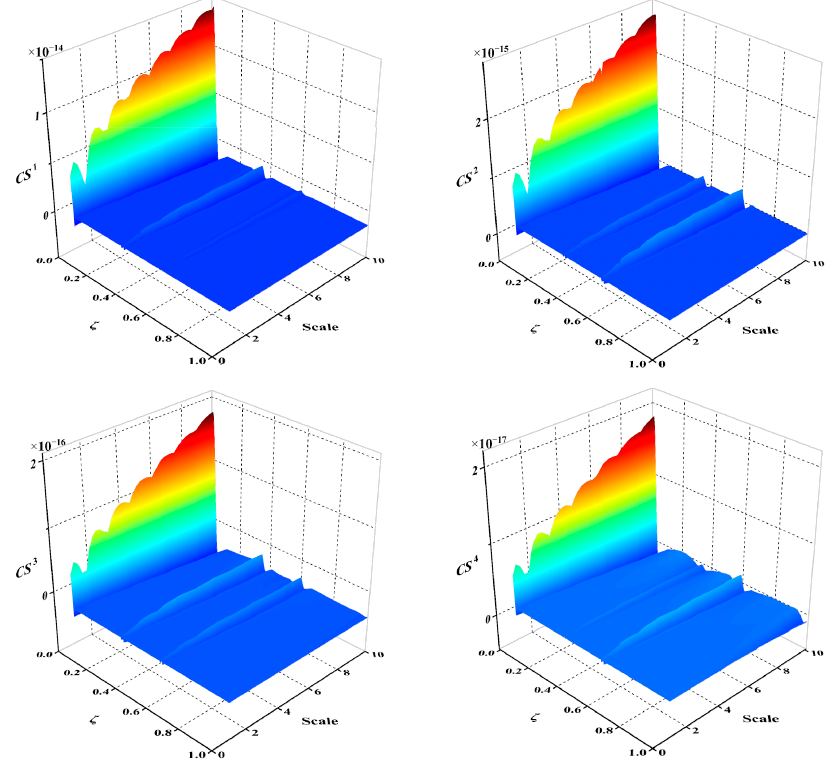
Figure 11. CS ( b , s ) without extension of SSSM boundary under scenario I. Figure 11. CS ( b, s ) without extension of SSSM boundary under scenario I.